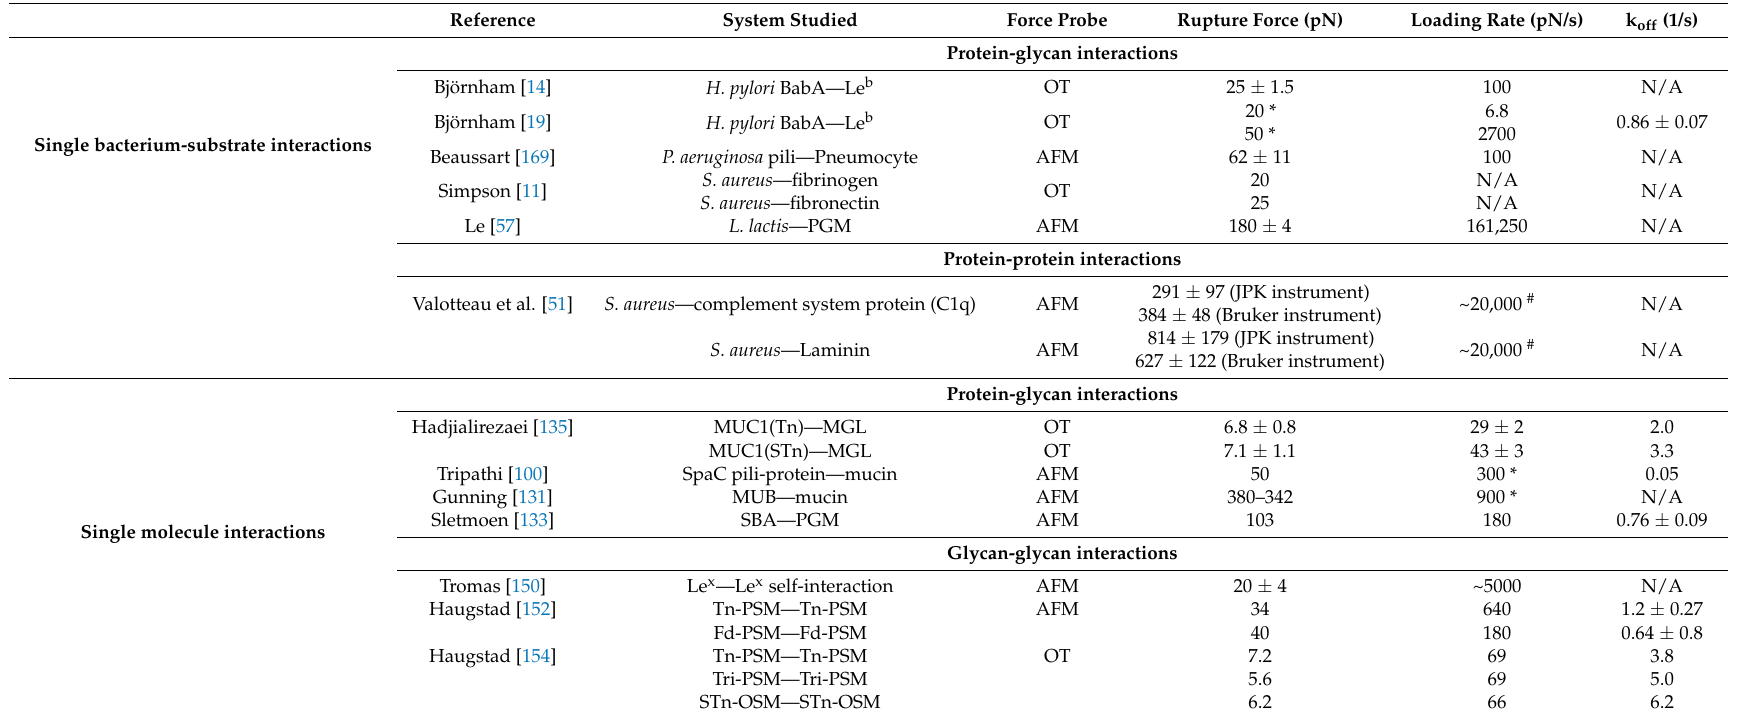
Table 1. The strength of protein—glycan and glycan—glycan molecular pair interactions determined using sensitive force